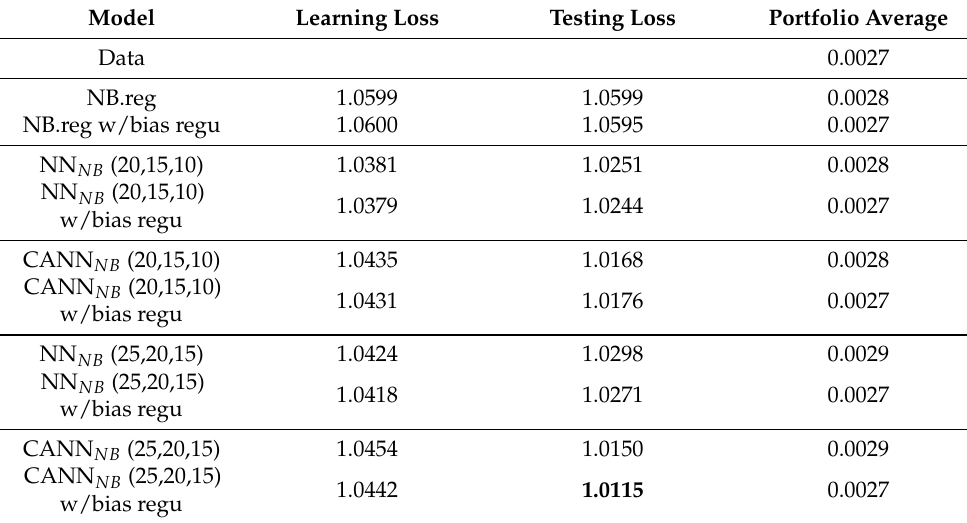
Table 9. Testing loss, learning loss, and portfolio average of regression and network-based models under negative binomial distributional assumptions with and without bias